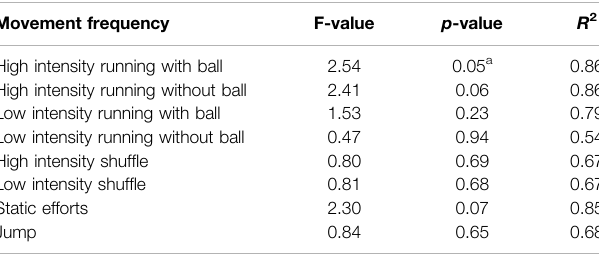
TABLE 4 | Prediction of the various movements classes from metabolites using regression analysis in backcourt